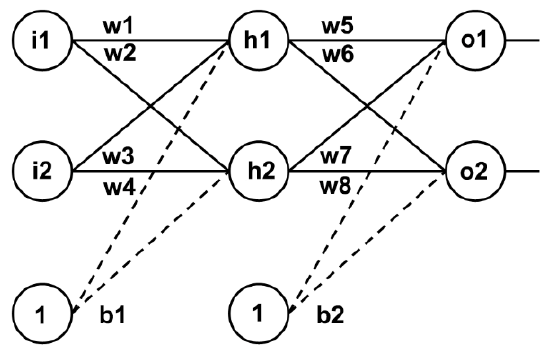
Figure 2. Structure diagram of a 3-layer BP neural network.